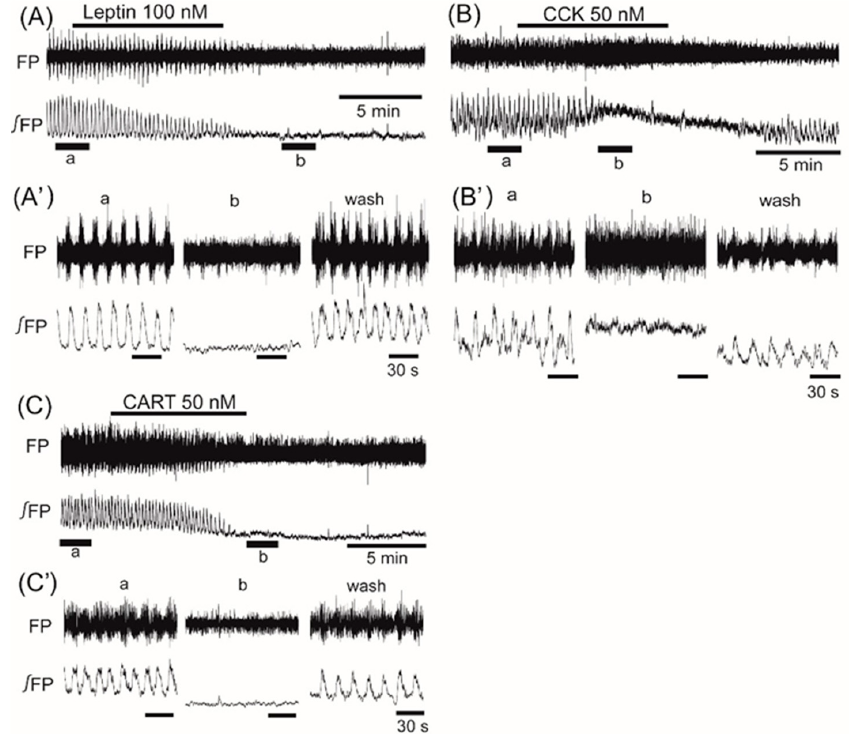
Figure 4. The effects of anorexigenic neuropeptides leptin, cholecystokinin (CCK), and cocaine- and amphetamine-regulated transcript (CART) on oscillation in the ventromedial hypothalamus. ( A , B , C ) Examples of continuous recordings of the ventromedial hypothalamus field potential before and after application of 100 nM leptin, 50 nM CCK, and 50 nM CART, respectively. ( A’ , B’ , C’ ) Faster sweep representations: a and b correspond to records at “a” and “b” in (A), (B), and (C), and after 20-min washout (wash). The frequency of the oscillation was decreased by the application of each of the peptides. Note that application of CCK increased background tonic activity. FP: raw field potential; ʃ FP: integrated field potential; wash: washout.